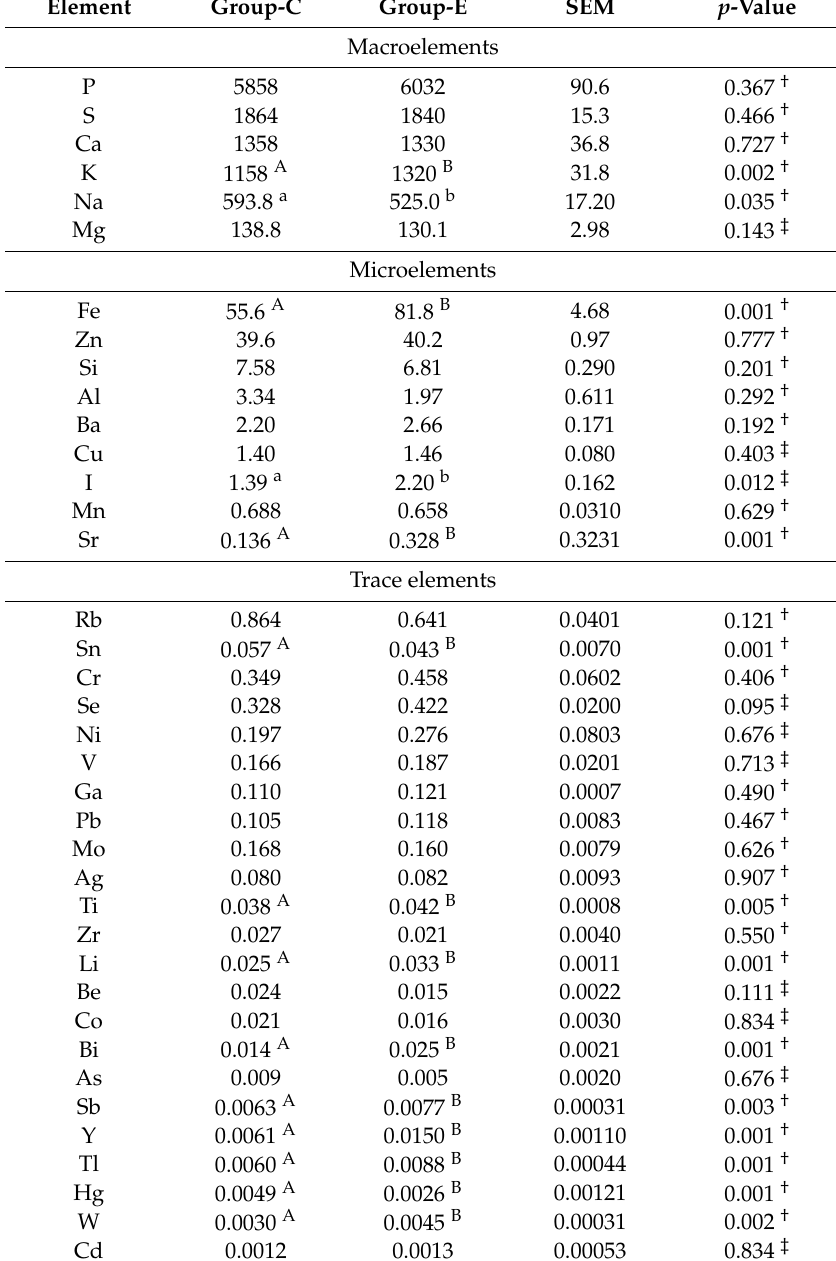
Table 4. The content of macro-, micro-elements and trace elements in the egg yolk (mg / kg wet wt). Element Group-C Group-E SEM p -Value